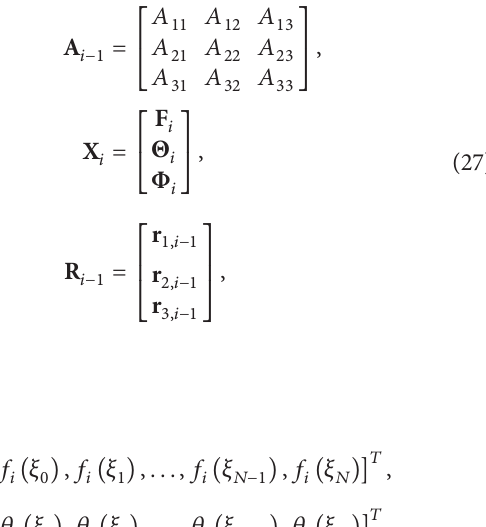
Table 1. Numerical solutions for the dimensionless